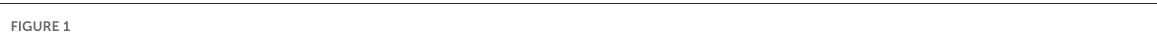
FIGURE1 whereas Class IV lead to impaired conductance. In Class V and VI, there is, respectively, less CFTR protein or the protein is less stable. (B) Shwachman-Bodian-Diamond type1, type2 and SBDS-like syndromes mainly impact acinar cell function. All disease-causing mutations impact the final maturation steps of ribosome biogenesis. (C) Johanson Blizzard syndrome mainly effects acinar cell function. UBR1 mutations cause defective recognition of misfolded proteins, which can therefore not be degraded by the proteasome. (D) Pearson and Shteyer syndrome lead to mitochondrial dysfunction. Acini seem more affected than ductal